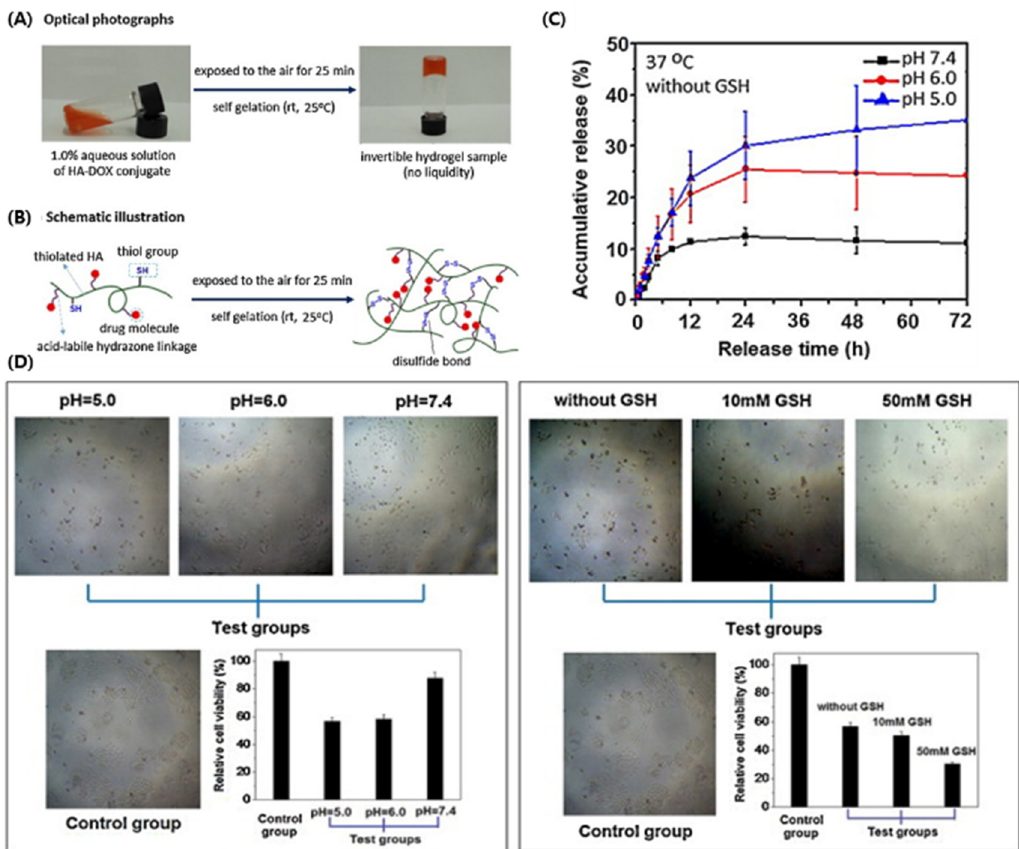
Figure 5. Dual stimuli-responsive drug release hydrogel. Optical photographs ( A ) and schematic illustration for the self-gelation ( B ) of aqueous 1.0 wt% HA–DOX conjugate solution when exposed to the air at room temperature (23 °C), and ( C ) pH-triggered drug release profiles of HA–DOX conjugate hydrogel. The photographs ( × 5) and relative viabilities of human nasopharyngeal carcinoma CNE2 cells: ( D ) treated with the release media of HA–DOX conjugate hydrogel under various pH conditions without glutathione (GSH) and treated with the release media of HA–DOX conjugate hydrogel in the absence and presence of GSH (10 and 50 mmol / L) when the pH value was kept at 5.0. Individual PBS (pH 7.4) was used as the control. Reproduced from [109], copyright permission by Elsevier 2017.